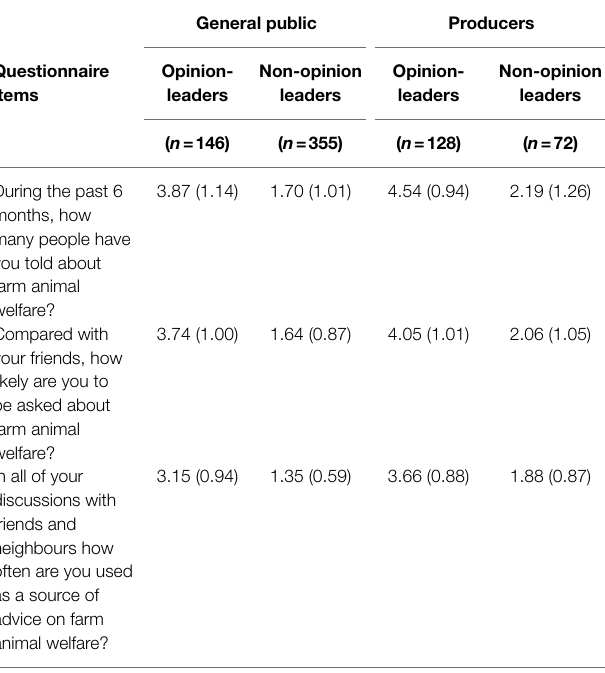
TABLE 1 | Attitude scale definitions. TABLE 2 | Group means for the two clusters identified among the general public and the red meat producers, opinion leaders and non-opinion leaders, standard deviations are provided in